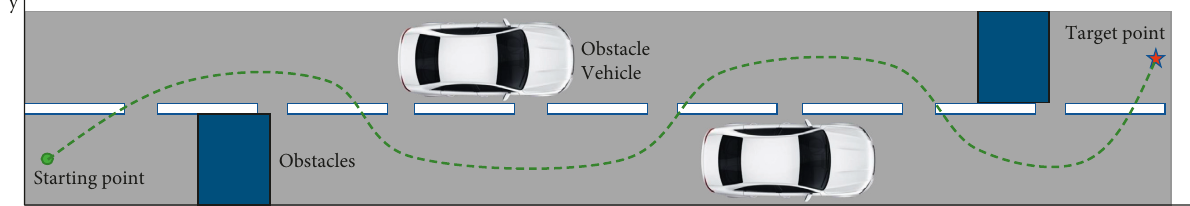
Figure 1: Schematic diagram of obstacle avoidance conditions.